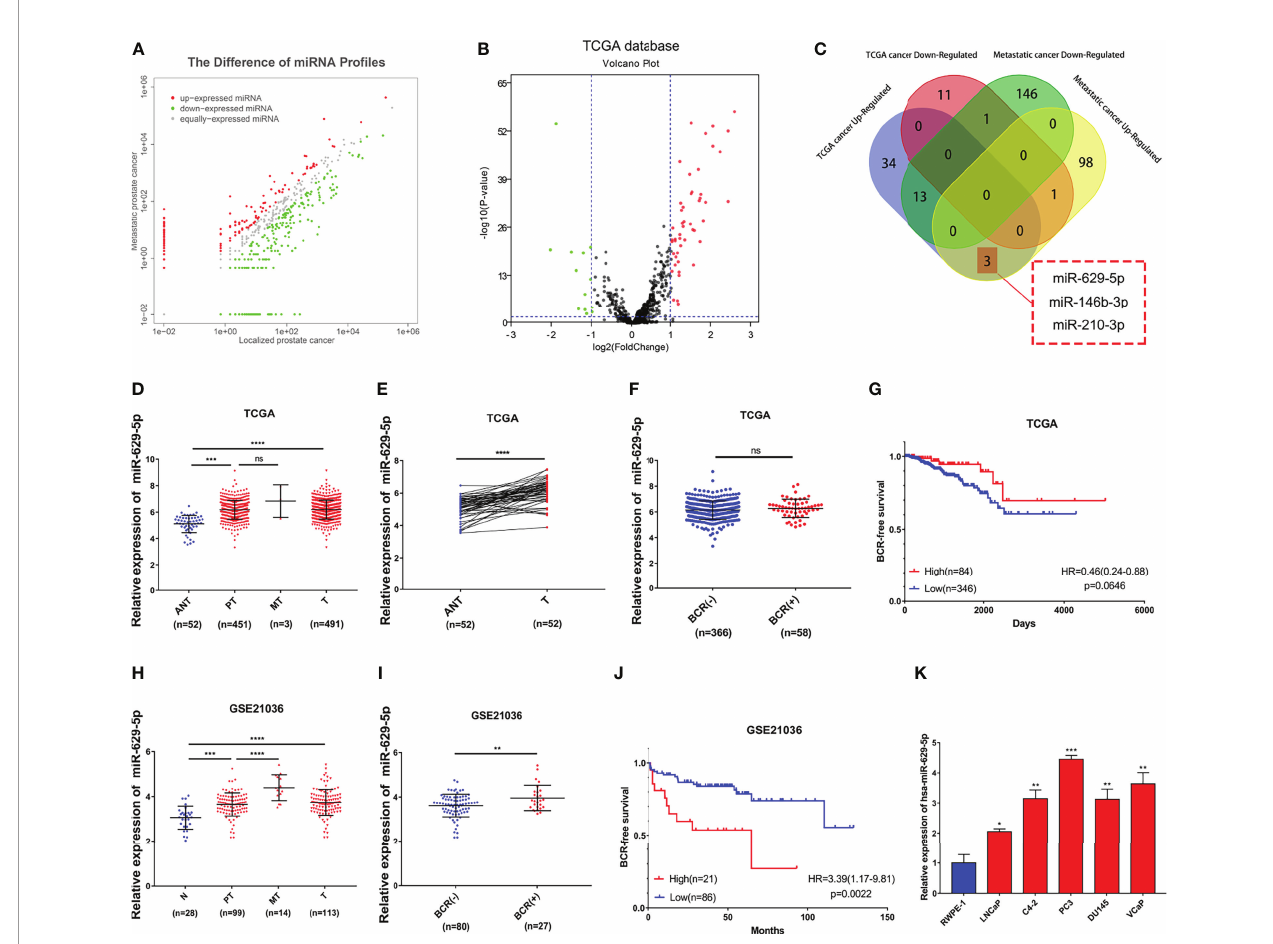
FIGURE 1 | Identify and verify miRNA associated with PCa progression by bioinformatics analysis. (A) The differential expression miRNA of clinical samples (102 upregulated/160 downregulated miRNAs related to PCa metastasis, threshold set as |log2(Fold Change)| ≥ 1, P < 0.05). (B) The differential expression miRNA of TCGA-PRAD database (50 upregulated/13 downregulated miRNAs related to PCa formation, threshold set as |log2(Fold Change)| ≥ 1, P < 0.05). (C) Identify key miRNAs related to PCa progression by combining clinical samples with TCGA database. (D) miR-629-5p expression increased in primary localized PCa tissues and metastatic PCa tissues compared with adjacent normal tissues in TCGA. (E) miR-629-5p expression levels was upregulated in 52 paired PCa tissues compared with that in the matching adjacent normal tissues in TCGA. (F) Correlations between miR-629-5p expression and patients ’ BCR status in TCGA. (G) The Kaplan-Meier survival analysis of BCR-free survival about miR-629-5p expression in TCGA. (H) miR-629-5p expression increased in primary localized PCa tissues and metastatic PCa tissues compared with normal tissues in GSE21036. (I) Correlations between miR-629-5p expression and patients ’ BCR status in GSE21036. (J) The Kaplan- Meier survival analysis of BCR-free survival about miR-629-5p expression in GSE21036. (K) Real-time PCR analysis of miR-629-5p expression in normal prostate epithelial cell (RWPE-1) and PCa cells. The data were presented as means ± SD from three biological replicates. ns P > 0.05; *P < 0.05; **P < 0.01; ***P < 0.001; ****P < 0.0001; Student ’ s t-test (D, F, H, I, K) ; paired t-test (E) . ANT, adjacent normal tissues; N, normal tissues; PT, primary localized PCa tissues; MT, metastatic PCa tissues; T, tumor tissues; BCR, biochemical recurrence; HR, hazard